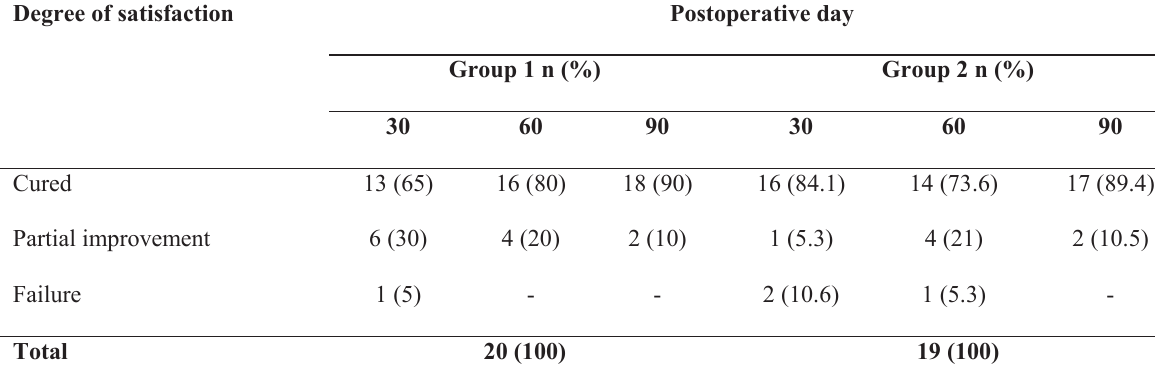
Group 1: hand-made sling; Group 2: commercial sling